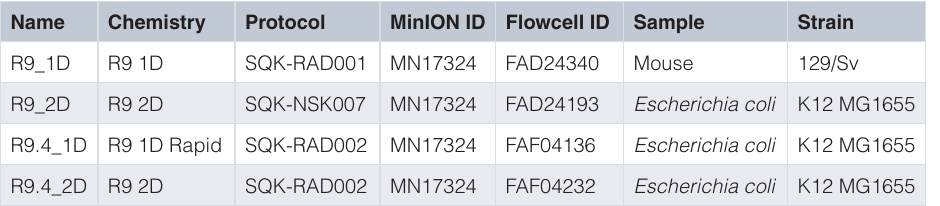
Table 1. Metadata for MinION datasets sampled to produce toy